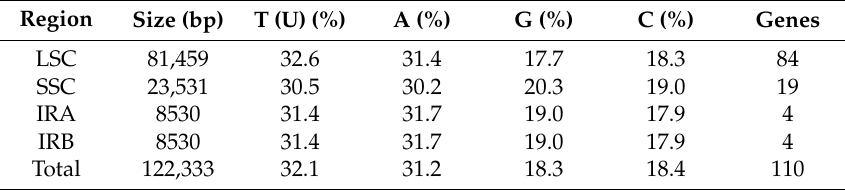
Table 1. Chloroplast genome composition of Rhipsalis baccifera